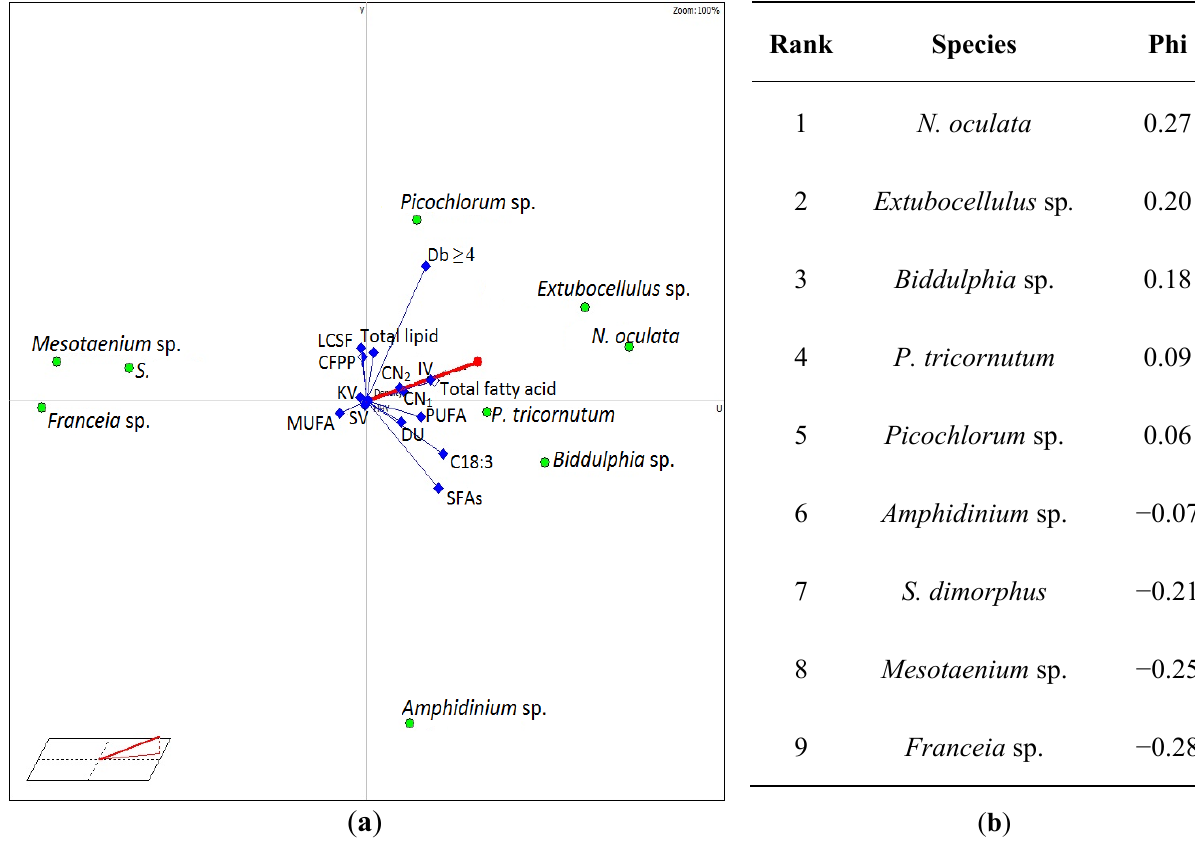
Figure 1. ( a ) Graphical Analysis for Interactive Assistance (GAIA) plot of nine microalgal species from the present study showing 16 criteria (14 biodiesel properties from Table 3, total lipid and fatty acid content from Table 1) and decision vector; and ( b ) corresponding ranking of species based on their outranking